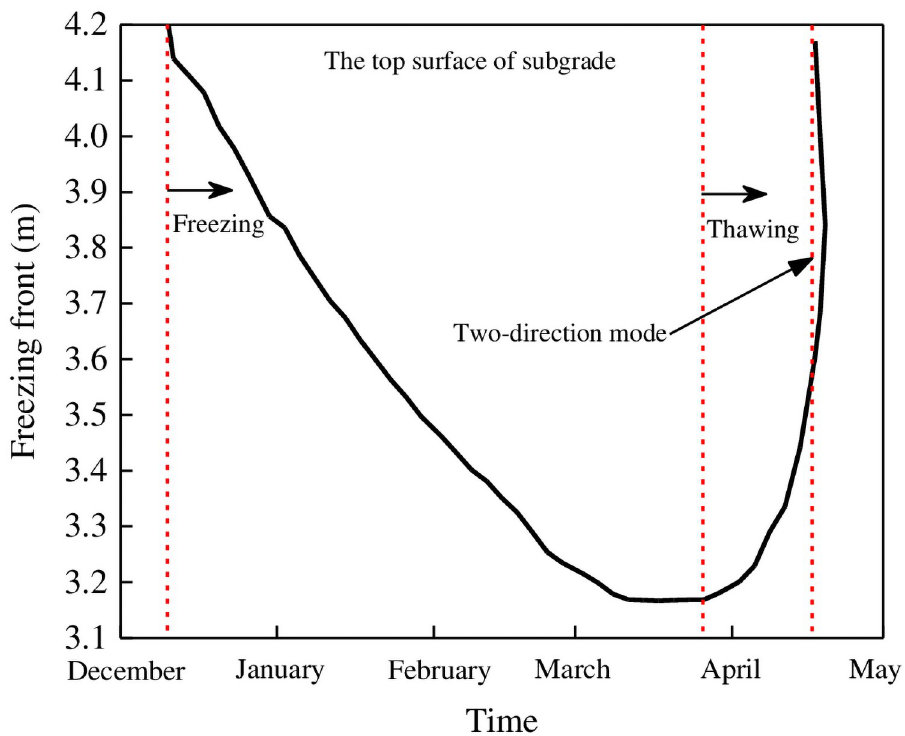
Fig 11. Calculated freezing depth beneath the centerline of the railway embankment section in the first year after construction.